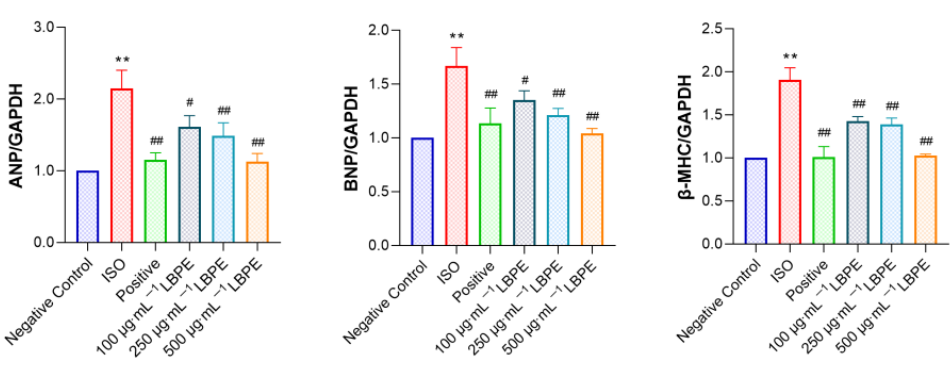
Figure 3. Effects of LBPE on the gene expression of hypertrophy markers in H9c2 cardiomyocytes (n = 3). ISO group vs. negative control group, ** p < 0.01. Positive and LBPE groups vs. ISO group, # p < 0.05, ## p < 0.01.